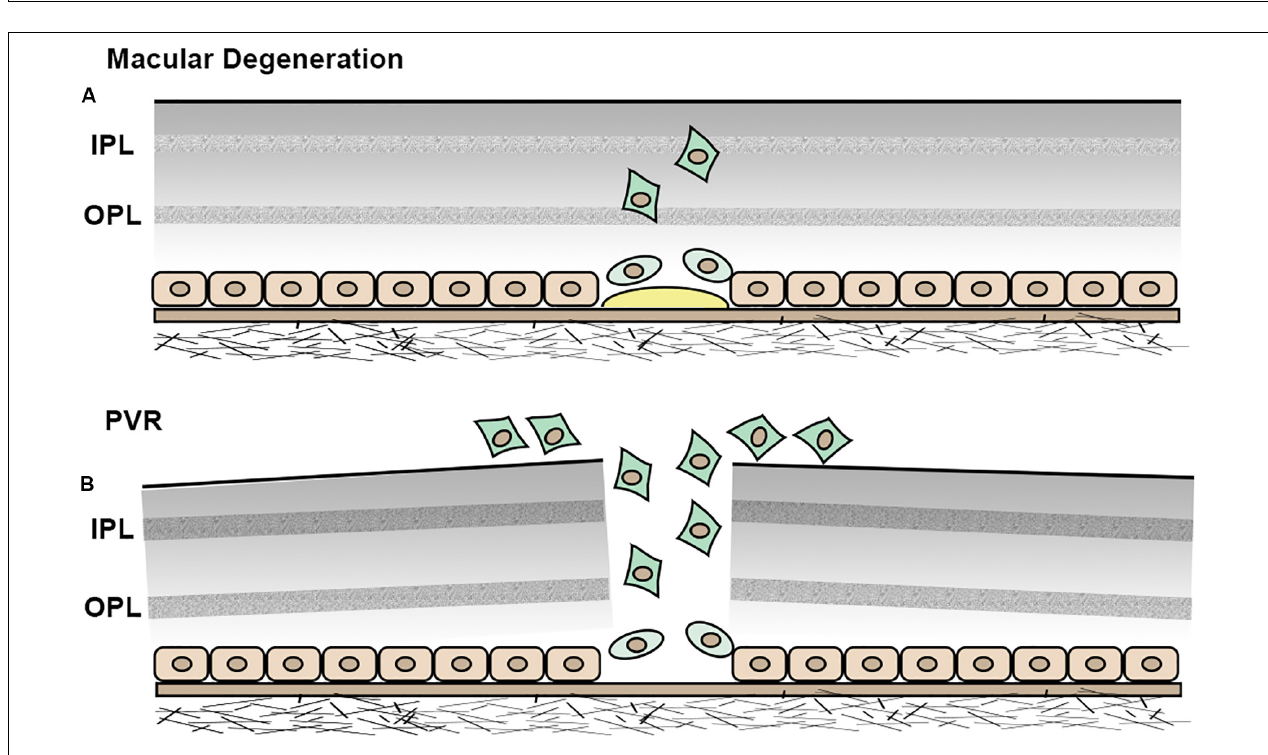
FIGURE 4 | Intraretinal hyperreflective foci (HRF) appear in OCT images in intermediate AMD. (A) Fundus photograph showing two hallmarks of intermediate AMD: sub-RPE deposits (black arrow) and pigment changes (white arrow). (B) OCT image demonstrating the presence of intraretinal HRF (white arrows) in intermediate AMD. The HRF correlate with pigment on funduscopic imaging (green line).